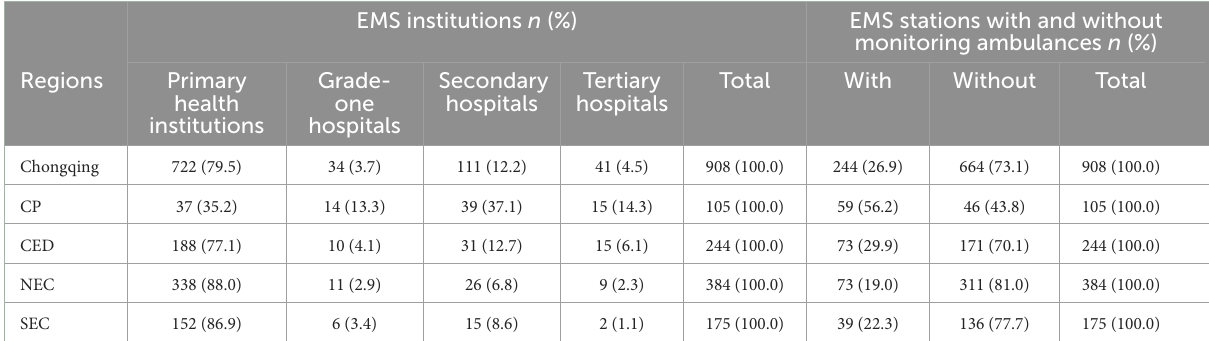
TABLE 2 Distribution of EMS institutions in